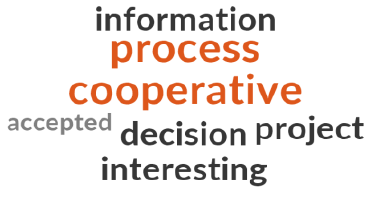
Figure 2. Word cloud of phrases that make up the Access category. Source: Own research. The more often a word appears, the larger the font.